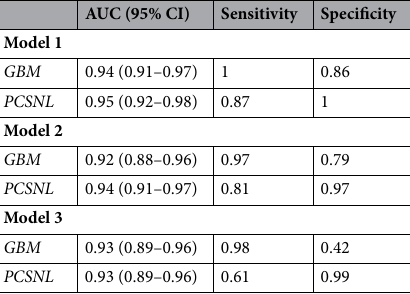
Table 2. Sensitivity, specificity and AUC metrics for each